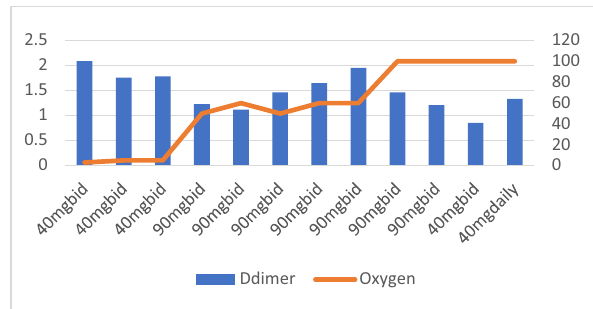
Figure 10: Patient number 10 presented at an early stage requiring nasal canula oxygen and D - dimer level was also moderately high (> 2 ) on presentation. The fi gure demonstrates that initial D - dimer trends decreased, but the oxygen requirements remained low until day 3 and then started to increase following increasing trends of D - dimer. The Enoxaparin dose was adjusted on day 4, but patient developed pneumothorax and pneumopericardium as well as had ST elevation myocardial ischemia leading to patient ’ s